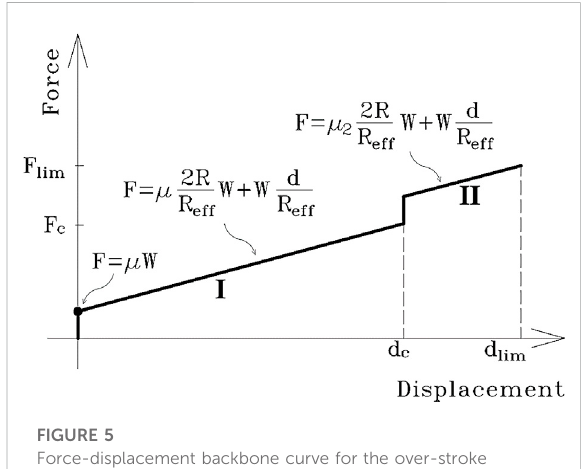
FIGURE 6 Force displacement test results from Furinghetti et al. (2021a) compared with the proposed analytical model for friction values: (A) 0.05; (B) 0.03; (C) 0.01.